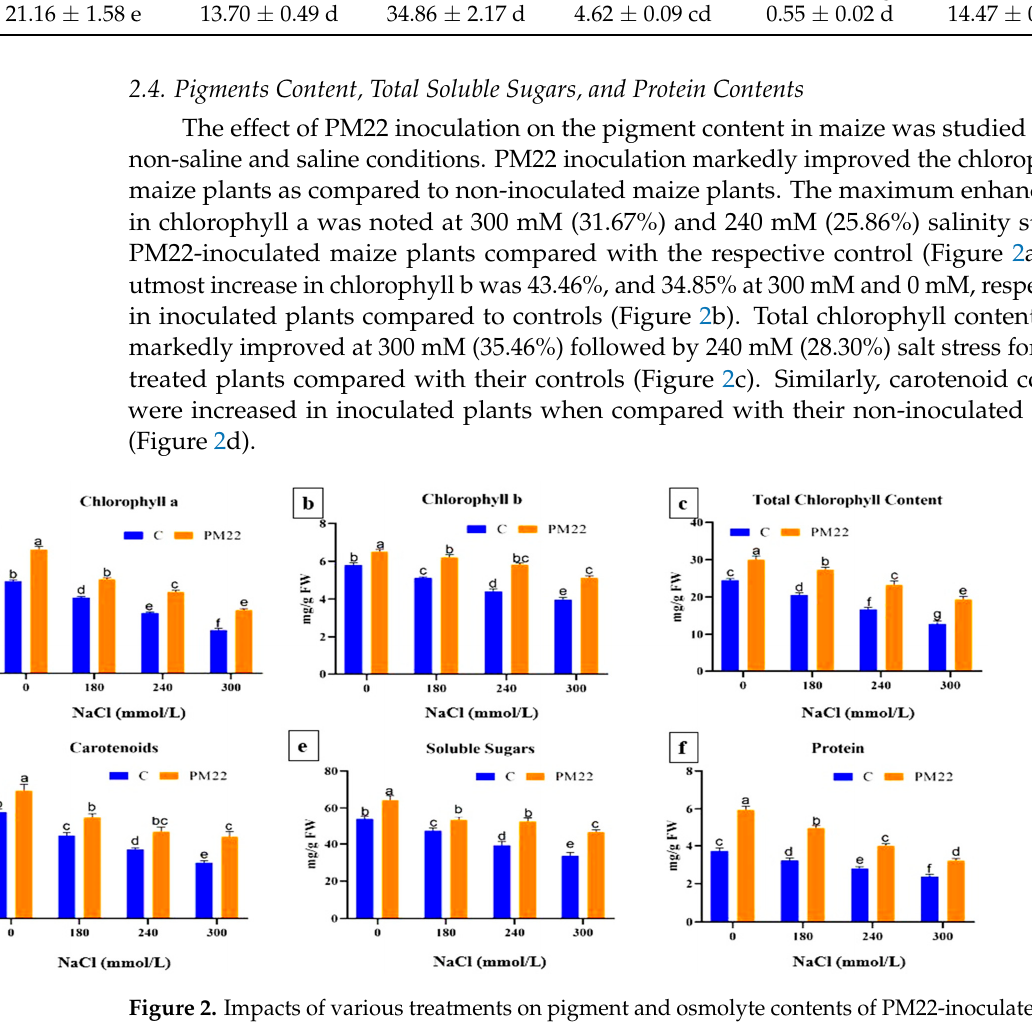
Figure 2. Impacts of various treatments on pigment and osmolyte contents of PM22-inoculated maize at different salt stress levels (0, 180, 240, and 300 mM). Soil containing non-inoculated seeds and soil with seeds inoculated with B. Safensis (PM22) were the two treatments. The values are the averages of three triplicates with standard errors of the mean. Different alphabets have significantly different values ( p = 0.05) from each other, according to Tukey’s least significant difference test. Changes in osmoprotectants content were studied in maize plants under NaCl stress with and without inoculation with PM22. A significant upsurge in total soluble sugars (TSS) and protein contents was recorded in plants with the application of salt stress. The PM22-inoculated plants were exposed to a maximum rise in TSS and protein under con- trol conditions (0 mM). In consideration of total soluble sugar contents, the maximum in- crease was observed at 240 mM (24.70%), then 300 mM (23.94%) NaCl when compared with the non-inoculated control (Figure 2e). Furthermore, protein contents were increased up to 37.41% at 300 mM NaCl stress as compared with non-inoculated plants (Figure 2f). 2.5. Relative Water Content and K + and Na + Content Salinity stress greatly affected the relative water content, potassium and sodium up- take. Maximum relative water content (RWC) was noted at 0 mM (20.37%) and 300 mM (14.55%) NaCl followed by 240 mM and 180 mM NaCl stress compared to maize plants without PM22 with applied salinity stress (Figure 3a). The elevation in Na + accumulation in maize plants was noted with an increase in salt level from 0 to 300 mM (3.42–5.51 mg/g FW). However, the application of salt stress to PM22-inoculated plants showed a reduced amount of Na + (7.89, 18.28, 24.07, 32.36%) compared with their respective controls (Figure 3c). Sodium chloride doses reduced K + influx in maize plants. Though, PM22 application with different levels of NaCl treatments showed a significant increase in K + accumulation (13.31, 23.04, 33.20, 35.95%) (Figure 3b).